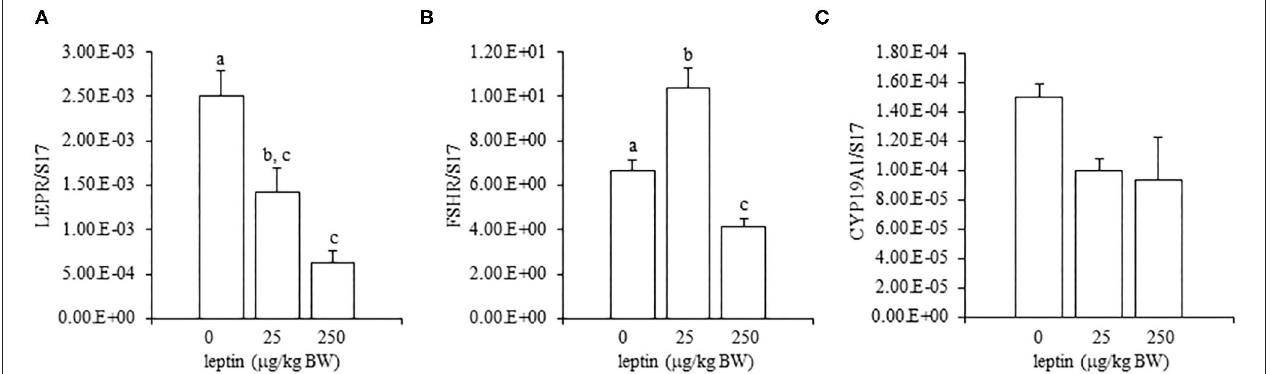
FIGURE 5 | Ovarian mRNA expression of LEPR (A) , FSHR (B) , and CYP19A1 (C) at 24h after leptin treatment in the 28-day-old chicks. Chicks were injected i.p. with 0, 25, and 250 µ g/kg BW of rmleptin. Bars with different superscripts are significantly varied. The data represent the mean ± SEM ( n = 6), and bars with different superscripts are significantly different.